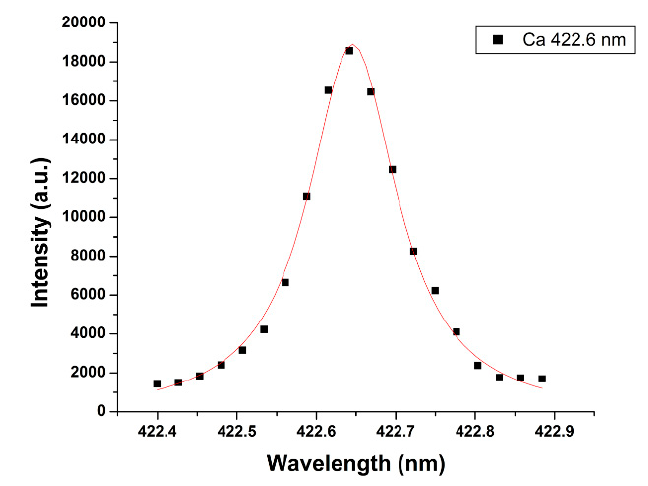
Figure 4. Measured and fitted Lorentzian of the Ca 422.6-nm line of the Dergaon Figure 4 . Measured and fitted Lorentzian of the Ca 422.6-nm line of the Dergaon meteorite.